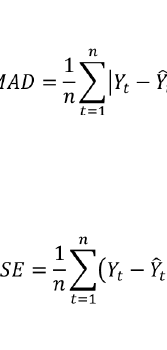
Mean Absolute Deviation